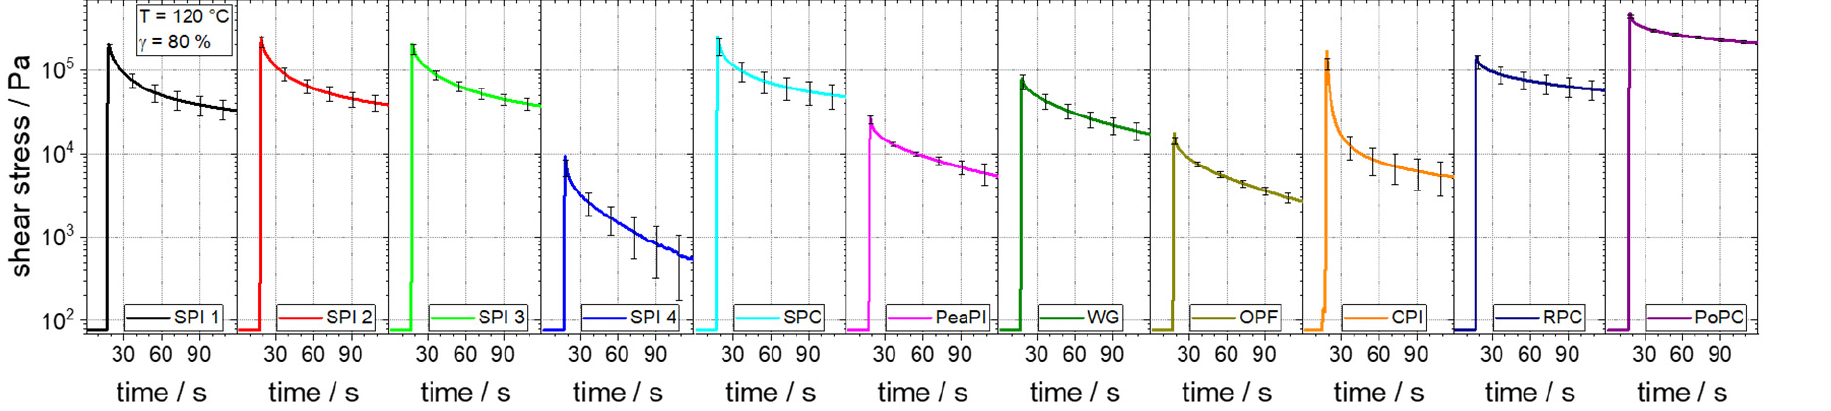
Figure 4. Stress relaxation tests at 120 ◦ C and a strain of 80% of different raw materials at a moisture content of